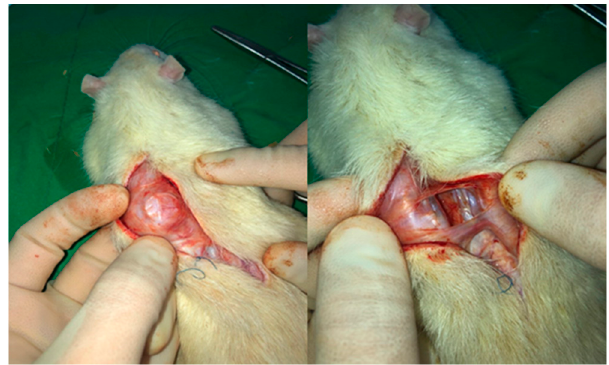
Figure 9. Rats sacrificed after eight weeks showing capsule formation around inserted samples.